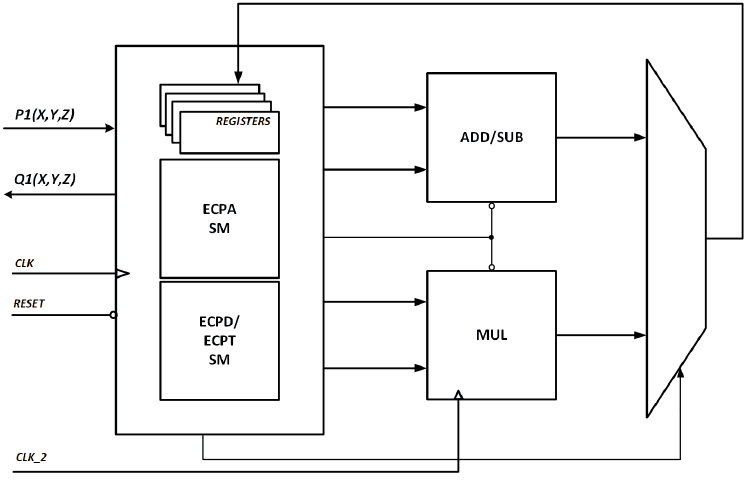
Figure 9. ALU unit